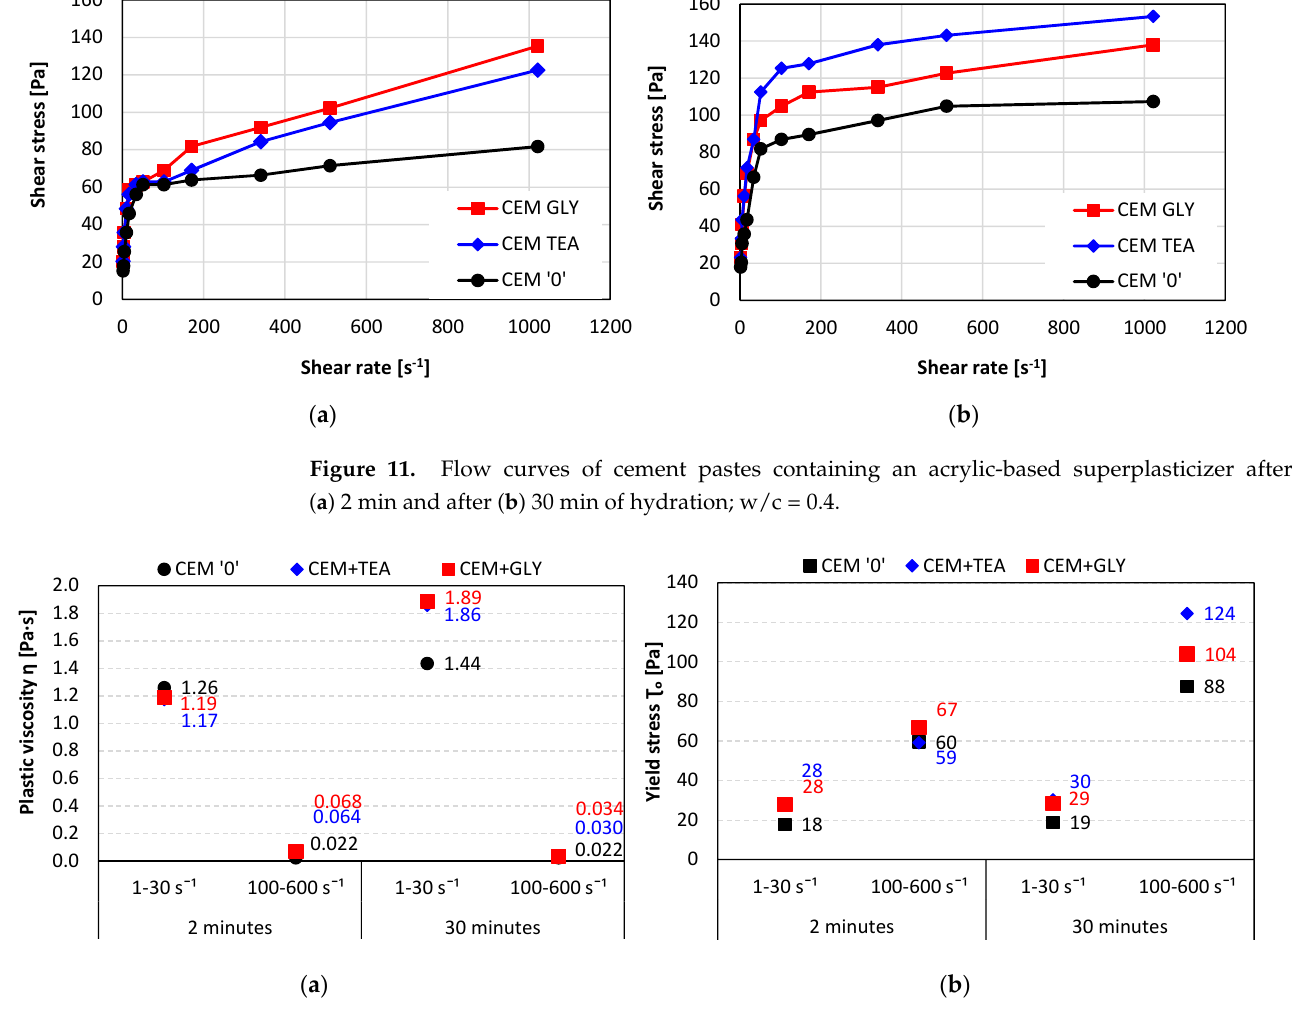
Figure 12. ( a ) Plastic viscosity and ( b ) yield stress of pastes containing an acrylic-based superplasti- cizer, w/c = 0.4.